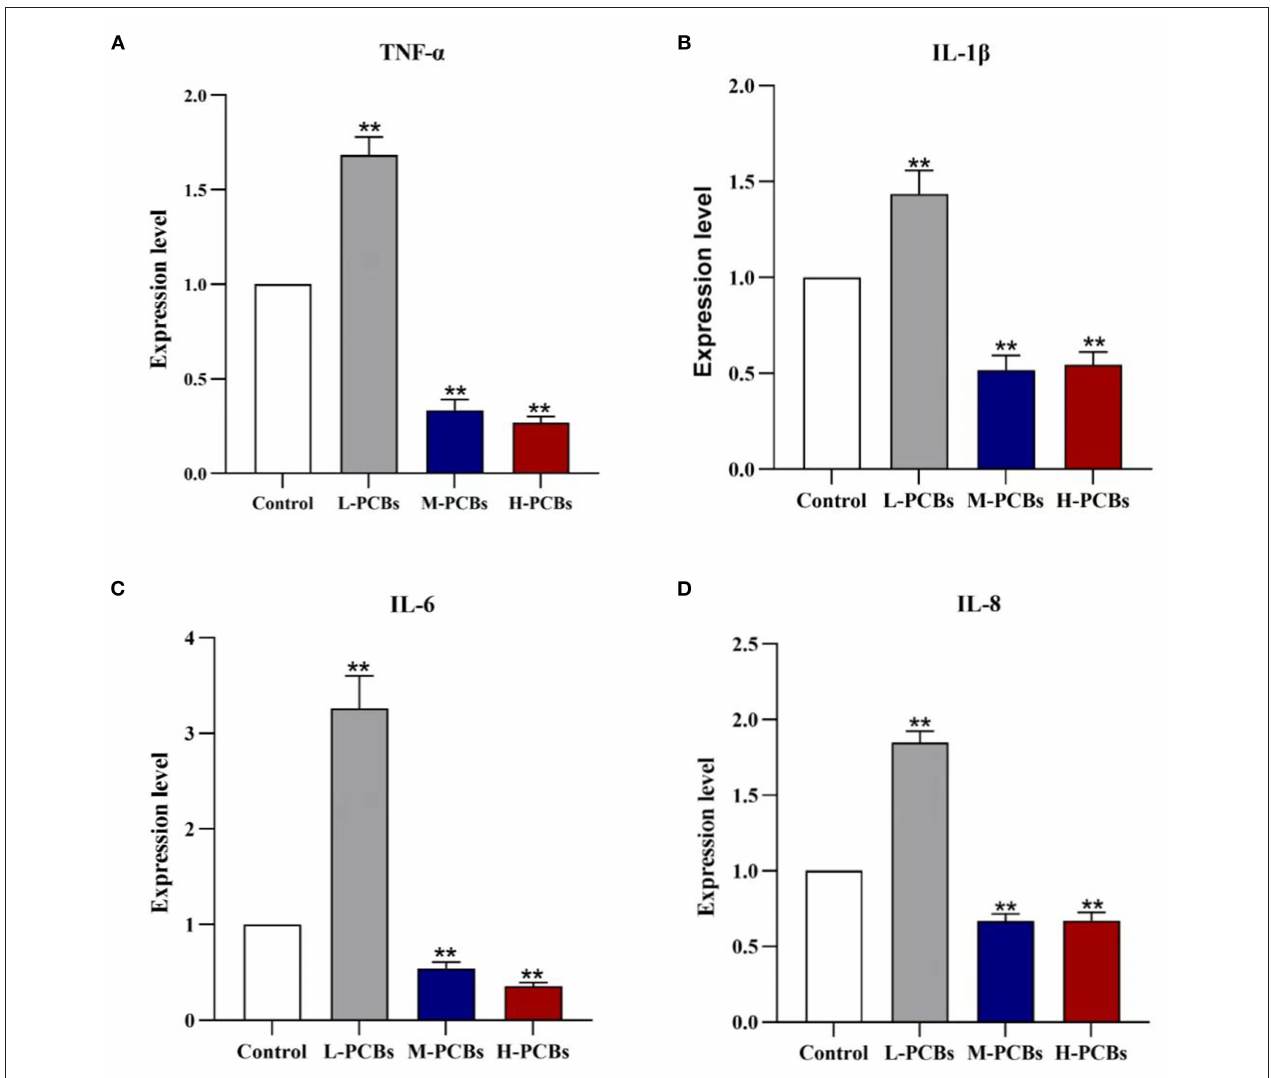
FIGURE 3 | Changes of cytokines (TNF- α ?IL-1 β ?IL-6 and IL-8) mRNA expression in zebrafish exposure to [ (A) . TNF- α (B) . IL-1 β (C) . IL-6 (D) .IL-8, * P < 0.05, ** P < 0.01 compared to control